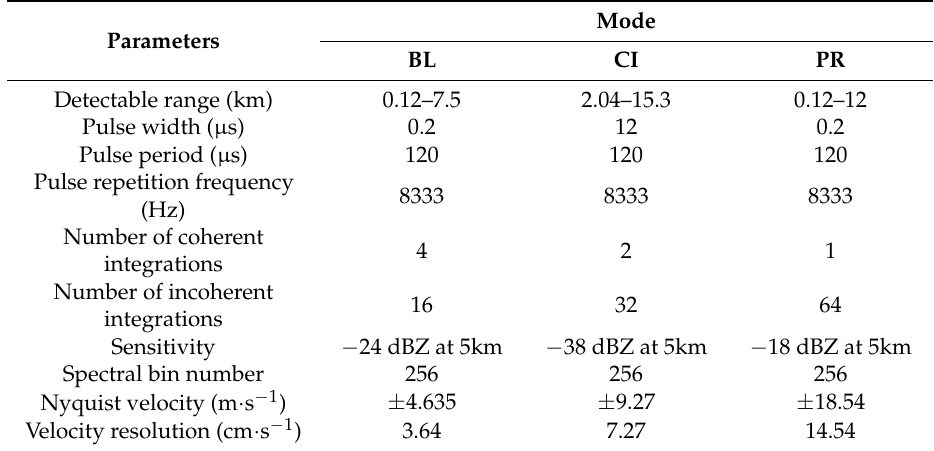
Table 2. Operational parameters of three modes. BL = boundary mode; CI = cirrus mode; and PR = precipitation